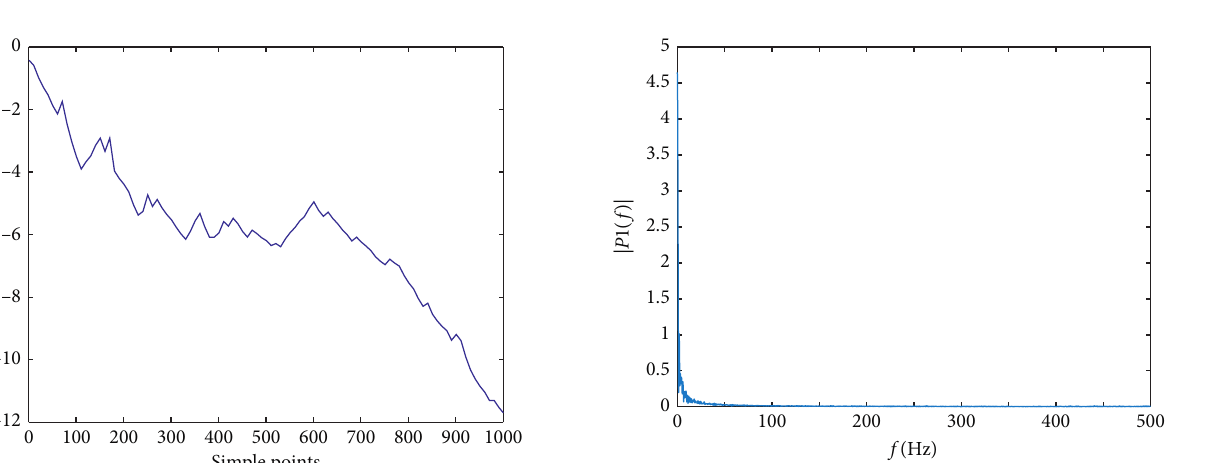
Figure 3: Original settlement